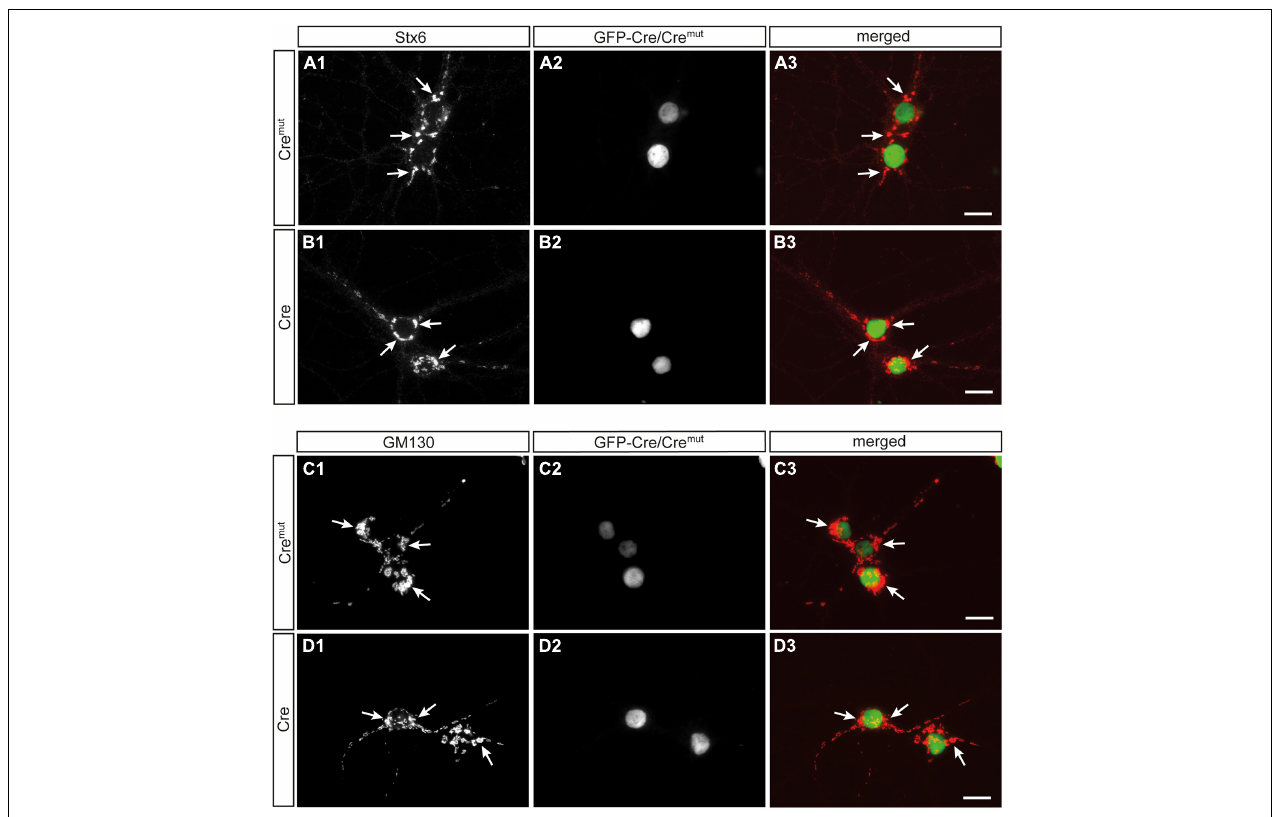
FIGURE 4 | Unchanged Golgi marker expression in β -Nrxn-deficient hippocampal neurons. (A,B) Primary hippocampal neurons from floxed β -KI mice were transduced with Cre mut (A 1 –A 3 ) or Cre (B 1 –B 3 ) expressing lentivirus and immunostained at DIV18 with anti-syntaxin 6 (Stx6) as a marker protein of the trans- Golgi network (tGN, A 1 ,B 1 ). Successful transduction with lentivirus is demonstrated by nuclear expression of inactive Cre mut or active Cre recombinase (Cre) fused to GFP (A 2 ,B 2 ) . Merged images (A 3 ,B 3 ) show similar distribution of Stx6 in the Golgi apparatus. Arrows, examples of Stx6-postive clusters. Scale bars: 20 µ m. (C,D) Cultured neurons as in panels (A,B) but immunostained against the cis -Golgi marker protein GM130 (C 1 ,D 1 ) with GFP-Cre autofluorescence indicating successful transduction of labeled neurons (C 2 ,D 2 ) . Merged images (C 3 ,D 3 ) reveal no difference in the absence of β -Nrxn. Arrows, examples of GM130-postive clusters. Scale bars: 20 µ m.